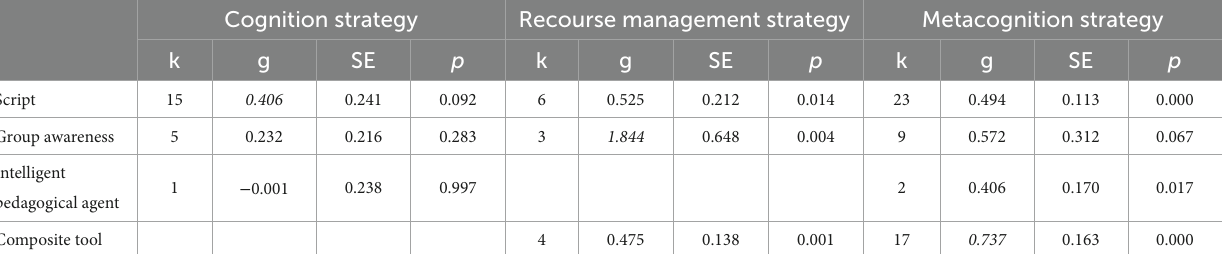
TABLE 8 Scaffolding’ effects by sub-category.